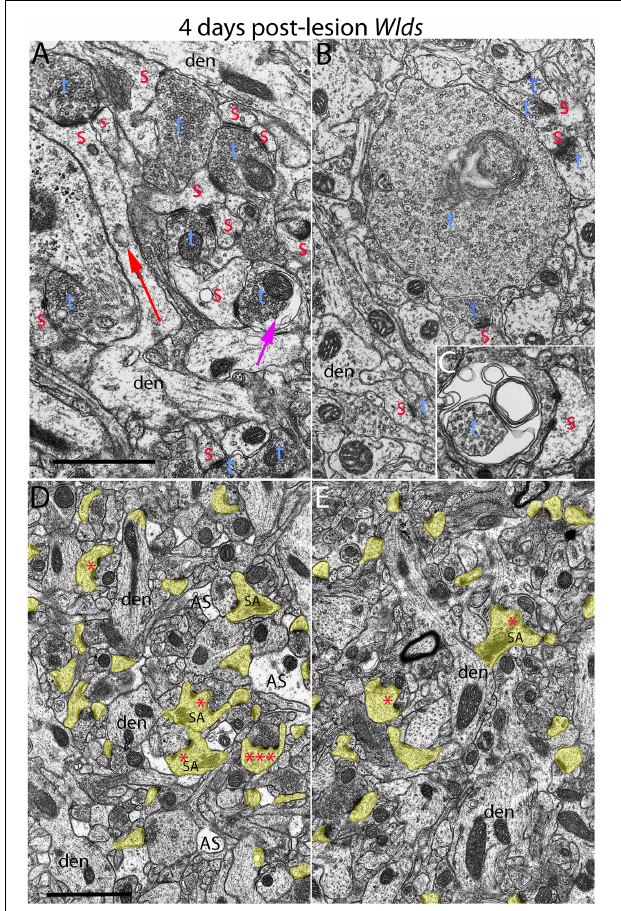
FIGURE 4 | Examples of synapses with abnormal morphologies at 4 days post-lesion in Wld s mice. (A) Synaptic terminal with washed out area (purple arrow) with other normal-appearing synaptic terminals. Note also very long spine neck (red arrow). (B) Exceptionally large presynaptic terminal filled with vesicles and complex whorls of membranes. (C) Presynaptic terminal with whorls of membranes and a membrane-bound sac containing vesicles. (D) Lower magnification view of chaliciform spines in the area of orphaned axons in Wld s mice (middle molecular layer). Note lighter astrocyte processes (AS) intermingled with synaptic terminals and dendrites. (E) Lower magnification view of chaliciform spines in the non-denervated inner molecular layer. Red s, spine head contacted by non-degenerating synapse; Blue t, non-degenerating synaptic terminal; den, dendrite; calibration bar in (B) = 0.25 µ m and applies to (A–C) . Calibration bar in (D) = 1 µ m and applies to (D,E) . *spinule; ***multiple